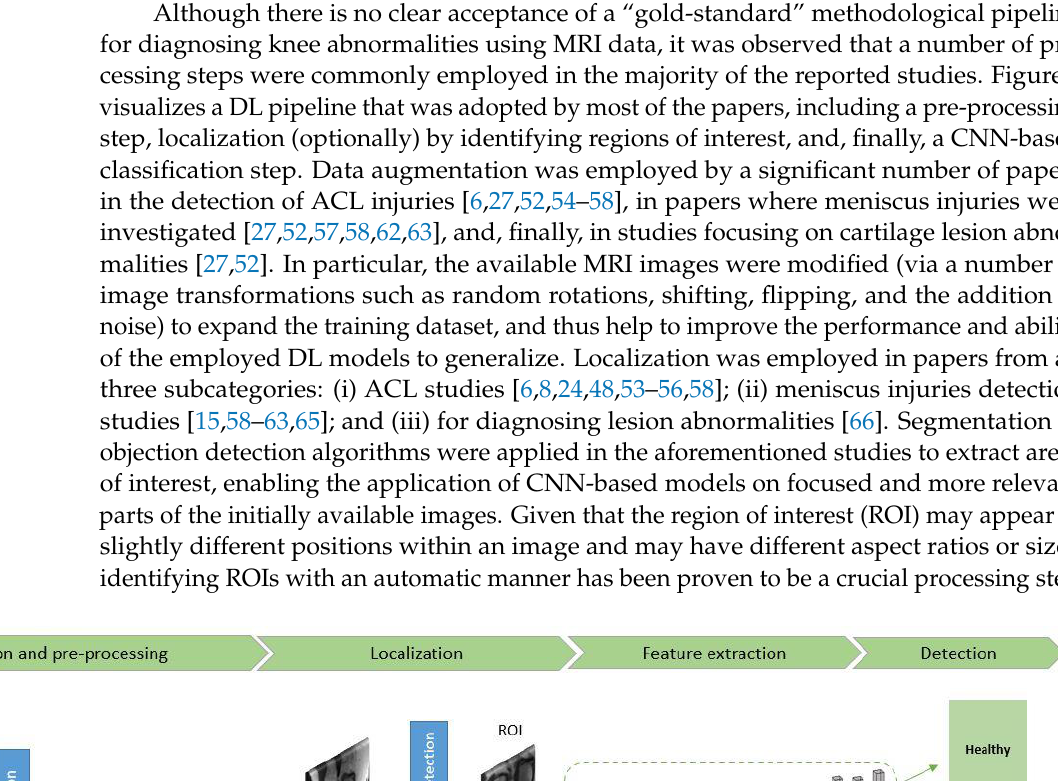
Figure 4. Temporal evolution chart depicting the number of ML papers per category published each year since 2013.